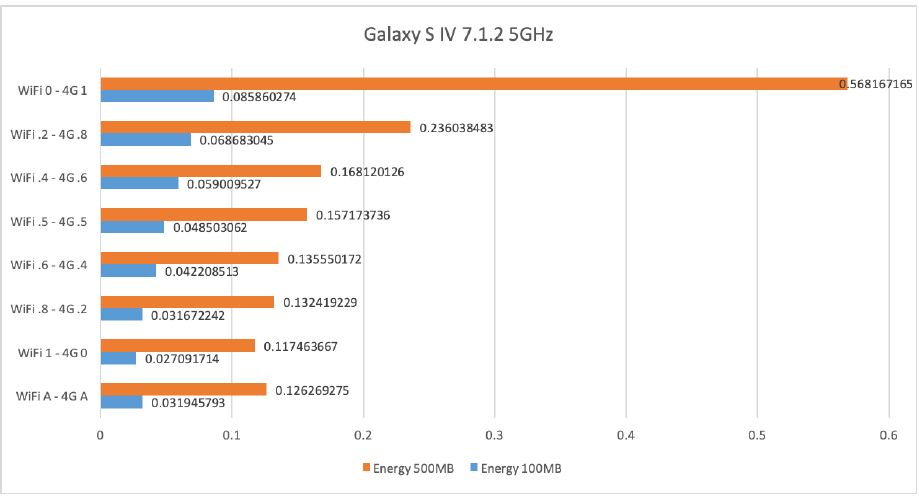
Figure 15. WiFi at 5 GHz and 4G energy consumption results for the Samsung Galaxy